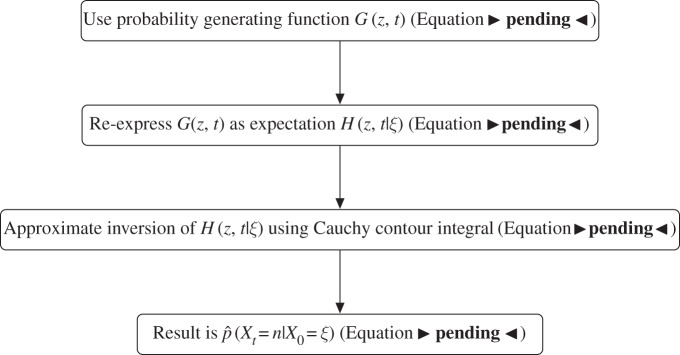
The main steps taken for deriving an expression for the number of bacteria n at time t starting from a probability generating function. ξ is the number of bacteria when t = 0, and z is a real or complex number.